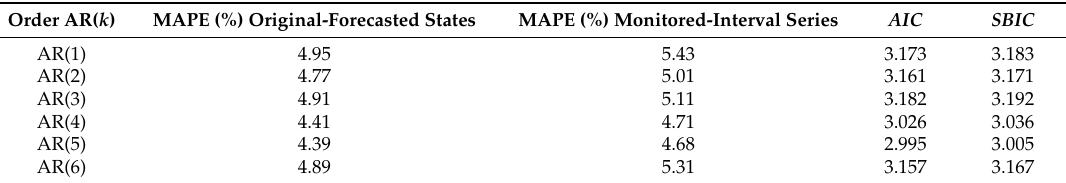
Table 6. Characteristics of the AR( k ) process.